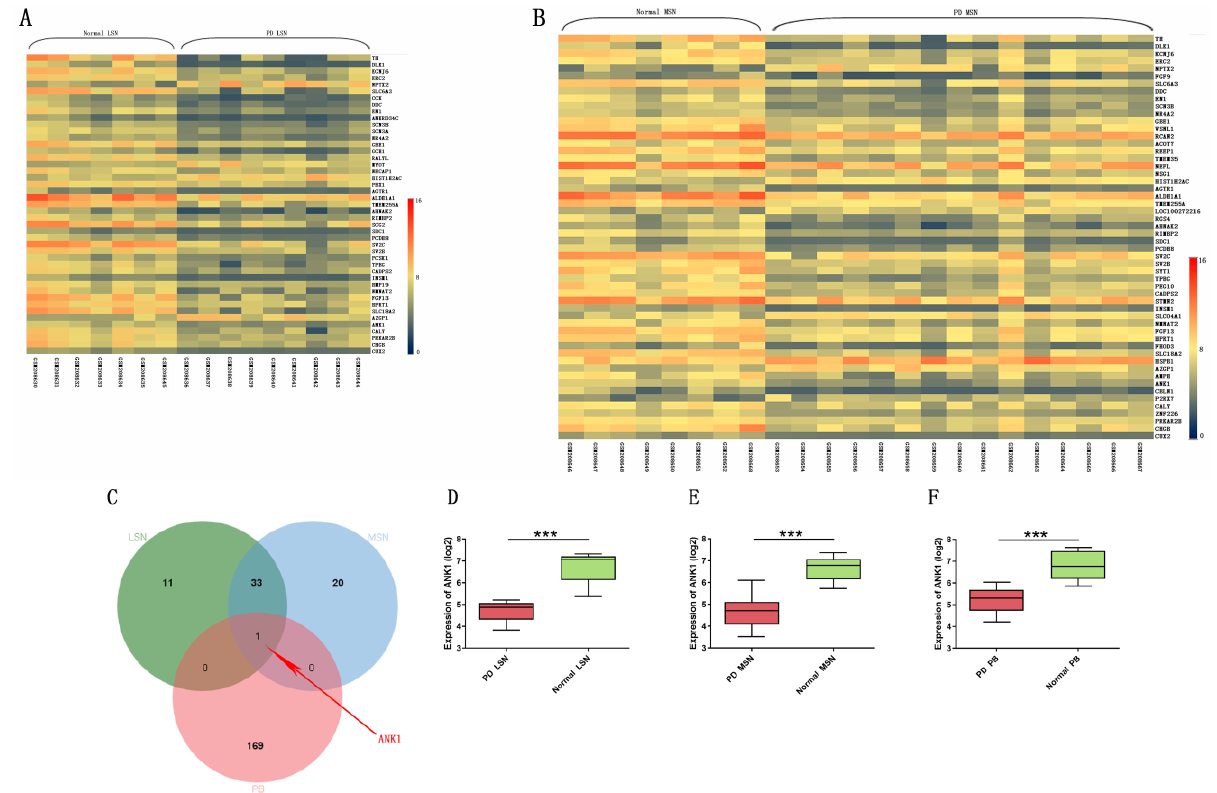
Figure 1. Ankyrin 1 ( ANK1) was identified as a down-regulated gene in Parkinson’s disease (PD) Gene Expression Omnibus (GEO) datasets. Differentially expressed genes (DEGs) expression heat maps in lateral substantia nigra (LSN) ( A ) and medial substantia nigra (MSN) ( B ). ( C ) Venn diagram of DEGs from GSE datasets. One gene was excavated as common DEG in three tissues, including LSN, MSN and blood. Differential expression of ANK1 in LSN ( D ), MSN ( E ) and blood ( F ). Data are expressed as mean ± S.E.M. Two groups were analyzed by Student’s t-test. *** p < 0.01.